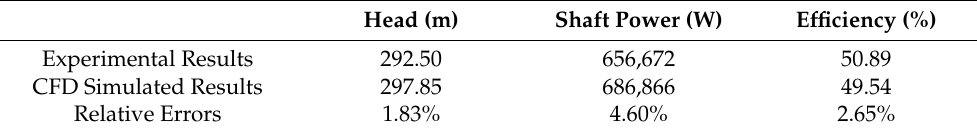
Table 3. Comparison of the experimental and CFD simulated results at rated conditions.